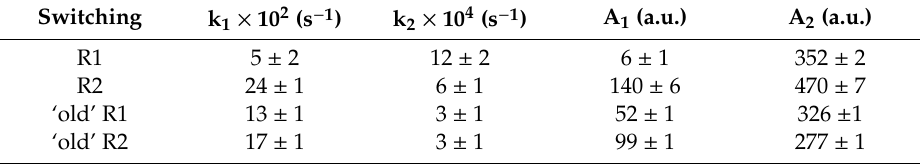
Table 2. Kinetic parameters in the reaction of ‘on’-‘off’-switching of red SAASoti forms (±